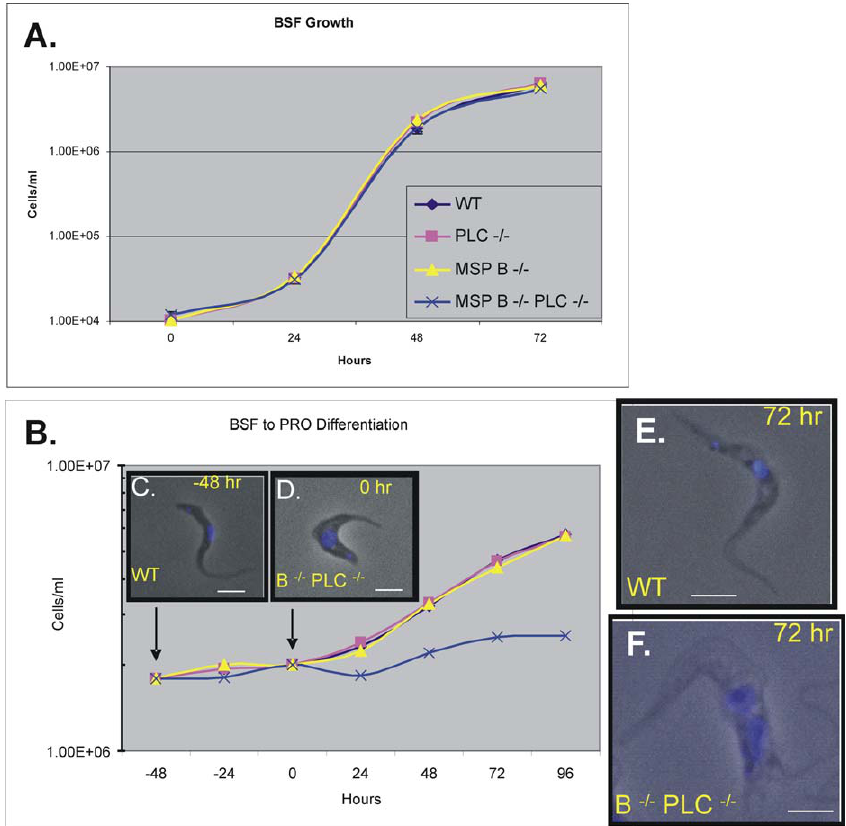
Figure 5. Single and Double Knock-Out BSF Cell Lines Grow Normally as BSF Cells, but B (cid:2) / (cid:2) PLC (cid:2) / (cid:2) Cells Exhibit a Growth Defect in Differentiation